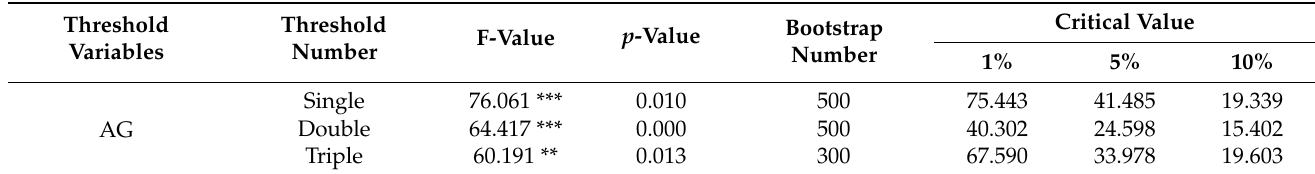
Table 5. Test results of the threshold effect.